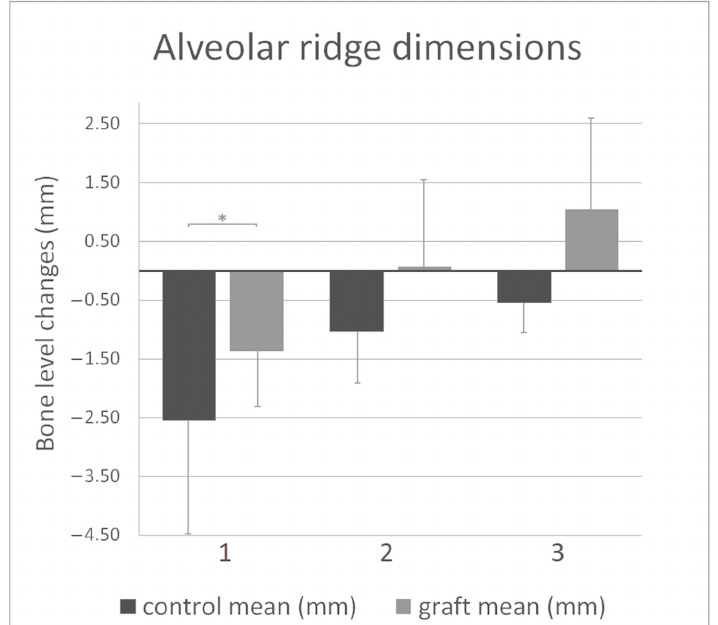
Figure 4. Alveolar ridge dimension changes at 1-year follow-up: (1) vertical buccal bone reduction; (2) horizontal bone reduction (control) and gain (graft) at 3 mm depth; (3) horizontal bone reduction (control) and gain (graft) at 5 mm depth. All data are presented as mean ± SD, Statistical significance ( p < 0.05) was marked by an asterisk. Table 3. Alveolar ridge dimension changes at 1-year follow-up. Abbreviations: One-way ANOVA test (#), independent- samples Mann-Whitney-U test (##). Group N Mean (mm) Std. Deviation (mm) p -Value vertical buccal bone reduction